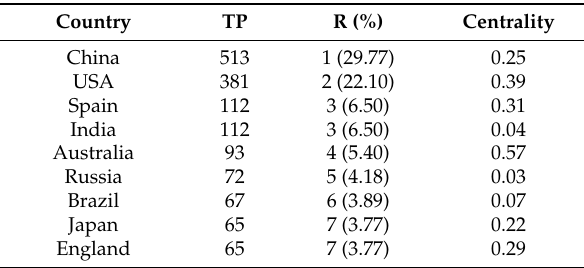
Figure 3. The cooperation network of the productive countries/territories of trace elements in coal and ash. Table 3. Contribution of the top 16 productive countries/territories of trace elements in coal and ash during 1971–2017.